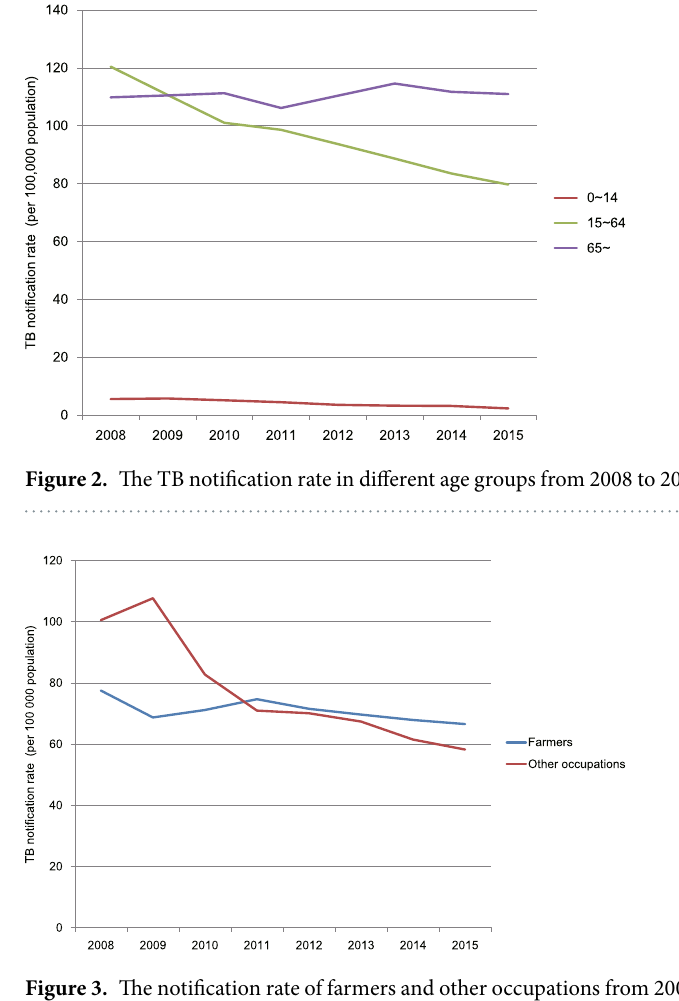
Figure 3. The notification rate of farmers and other occupations from 2008 to